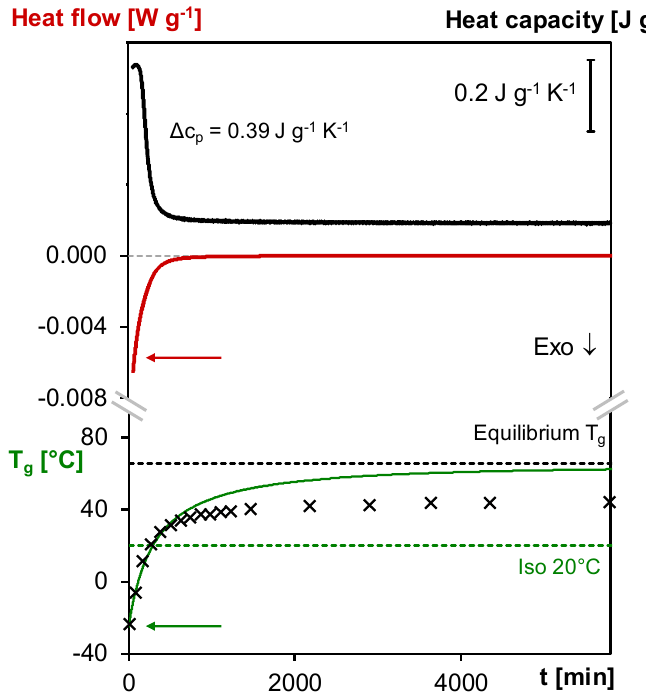
Figure 7. MTDSC, microcalorimetry, simulated and experimental evolution of the T g as a function of time at 20 °C of the 3M ‐ 3F630 system. Full black line : (specific) heat capacity measured in MTDSC; Full red line : heat flow measured in microcalorimetry; Full green line : simulated evolution of the T g ; Black crosses : experimental T g measured at different time of cure at 20 °C; Black dashed line : equilibrium T g at 20 °C based on the kinetics model; Green dashed line : T cure (20 °C).